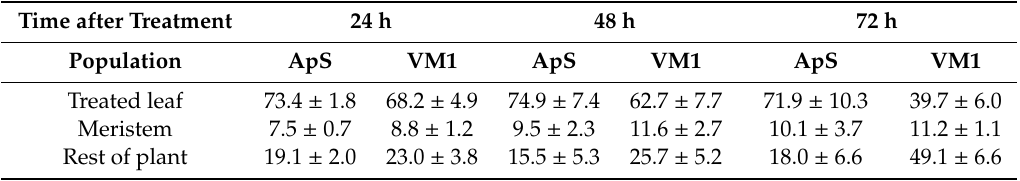
Table 3. Means and standard errors for radiochemical recovered, expressed as percentage glyphosate absorbed in the standard sensitive ApS and VM1 A. palmeri